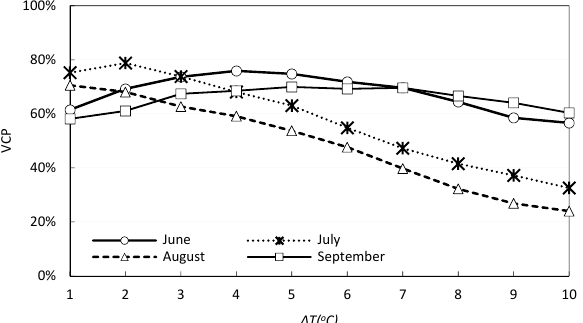
Figure 6. Monthly breakdown of the VCP 2 profile in Seoul.